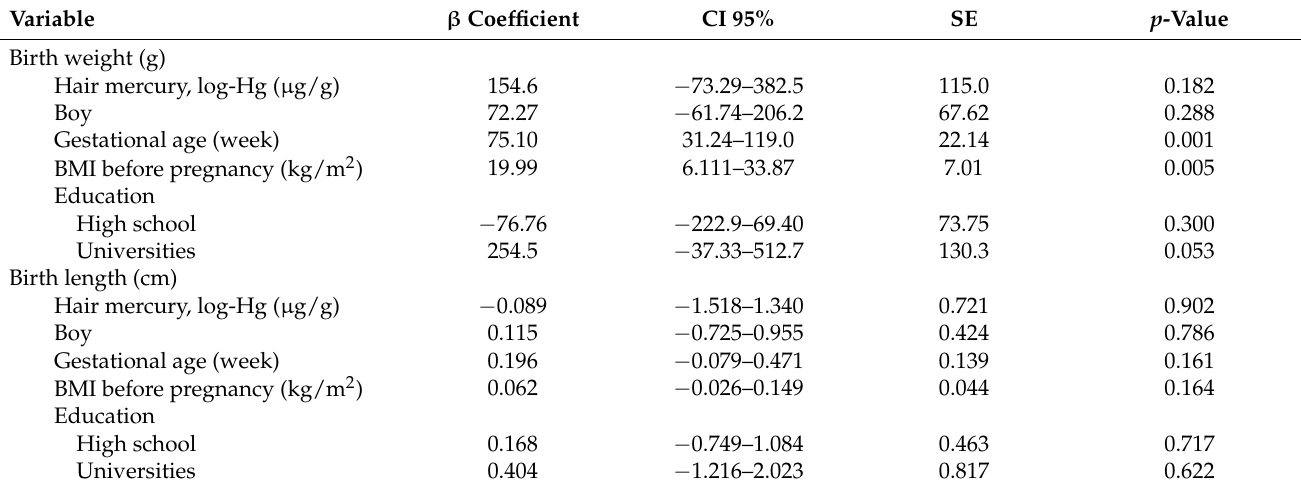
Table 5. The association between maternal hair mercury levels with birth weight and length of